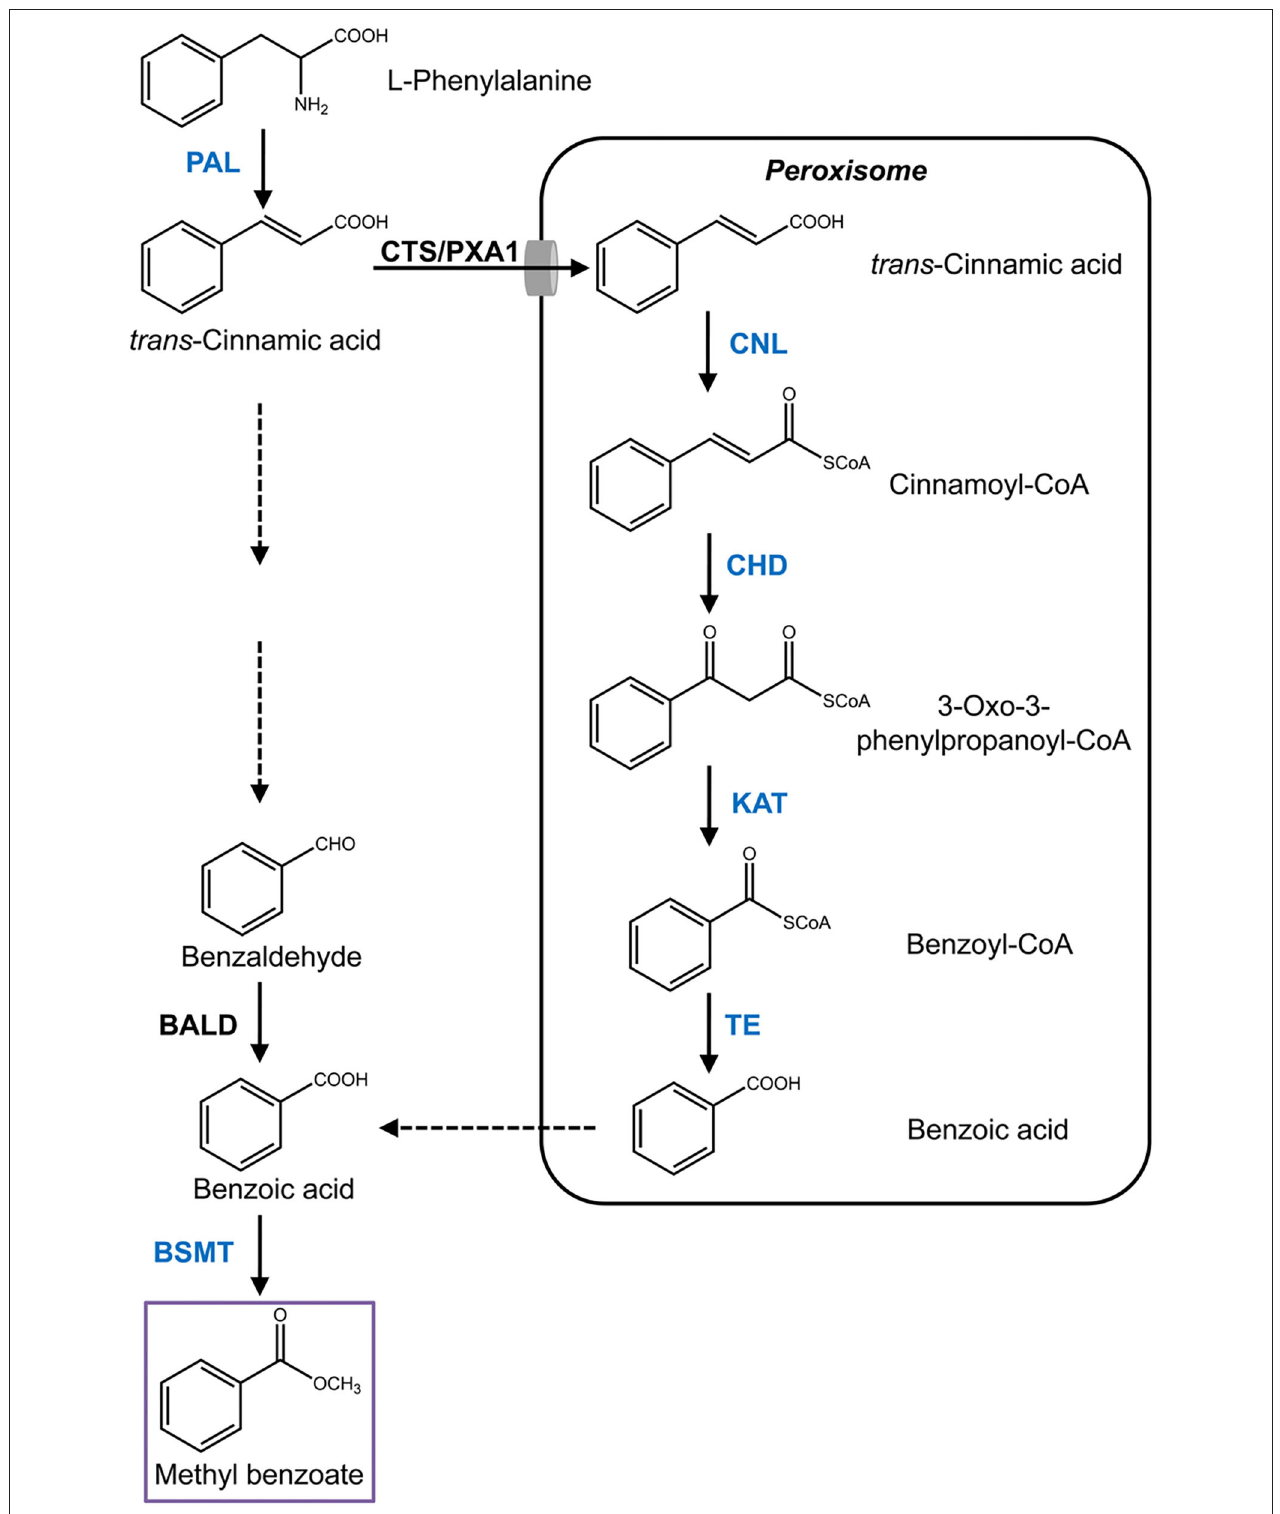
FIGURE 1 | Proposed pathway of methyl benzoate biosynthesis in H. coronarium . Enzymatic steps with coordinated gene expression in H. coronarium are shown in blue. Broken arrows represent hypothetical steps not yet described in plant. BALD, benzaldehyde dehydrogenase; BSMT, benzoic acid/salicylic acid carboxyl methyltransferases; CHD, cinnamoyl-CoA hydratase/dehydrogenase; CTS/PXA1, COMATOSE/peroxisomal ABC Transporter1; CNL, cinnamoyl-CoA ligase; PAL, phenylalanine ammonialyase; KAT, 3-ketoacyl CoA thiolase; TE, thioesterase.